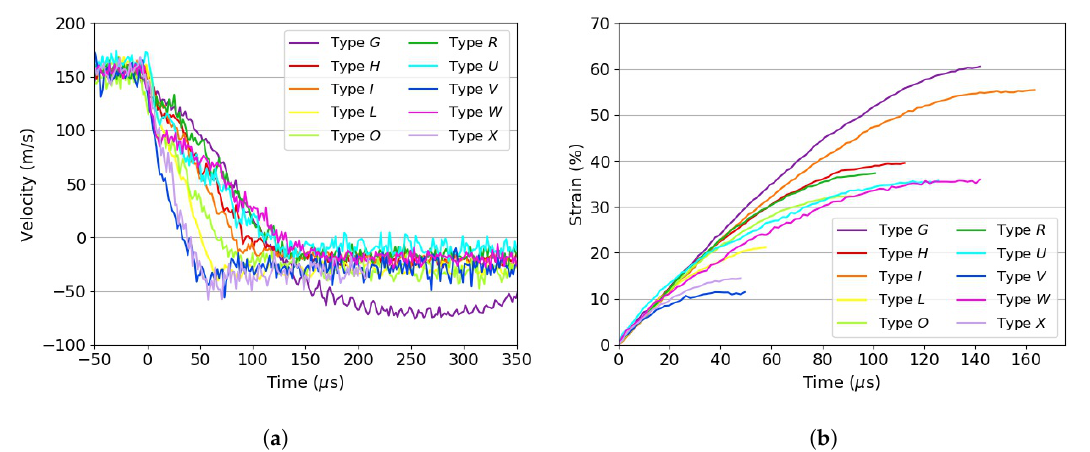
Figure 11. Dynamic test results for the investigated materials. ( a ) Velocity vs. time history; ( b ) strain vs. time